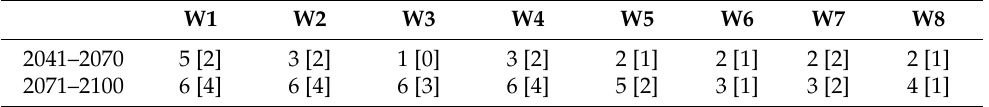
Figure 5. Changes in annual groundwater recharge ( Δ GWR) between the reference period (1981 − 2010) and the 2041 − 2070 and 2071 − 2100 periods as a function of ( a ) changes in mean annual temperature ( Δ T) and annual precipitation ( Δ P), ( b ) annual precipitation changes ( Δ P), ( c ) mean annual temperature changes ( Δ T), ( d ) mean cold month temperature changes ( Δ T CM ) and cold month precipitation changes ( Δ P CM ), ( e ) cold month precipitation changes ( Δ P CM ), ( f ) mean cold month temperature changes ( Δ T CM ), ( g ) cold month groundwater recharge changes ( Δ GWR CM ), and ( h ) annual actual evapotranspiration changes ( Δ AET). Table 6. Number of simulations with significant changes in groundwater recharge between the 1981 − 2010 reference period and the future periods for the eight watersheds (W1 to W8); the number of scenarios based on RCP8.5 producing significant changes is indicated in brackets.